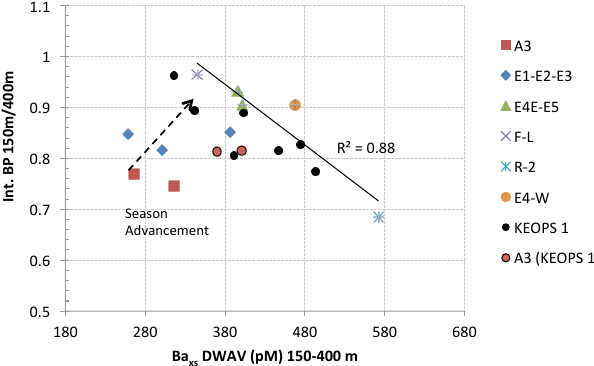
Figure 5. Regression of the ratio of integrated bacterial production (BP) in the upper 150m over integrated BP in the upper 400m ver- sus depth-weighted average (DWA) mesopelagic Ba xs (pM; 150– 400m) during KEOPS 2. KEOPS 1 data (dots) are reported for comparison (Christaki et al., 2008; Jacquet et al.,